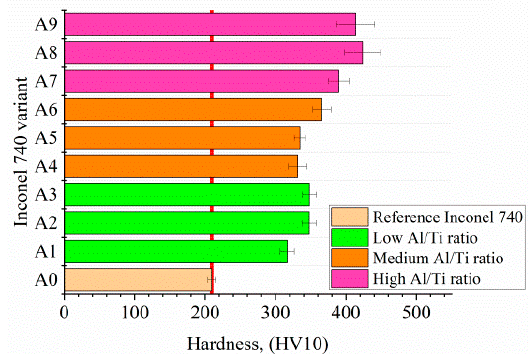
Figure 15. Hardness of the reference Inconel 740 and modified variants.